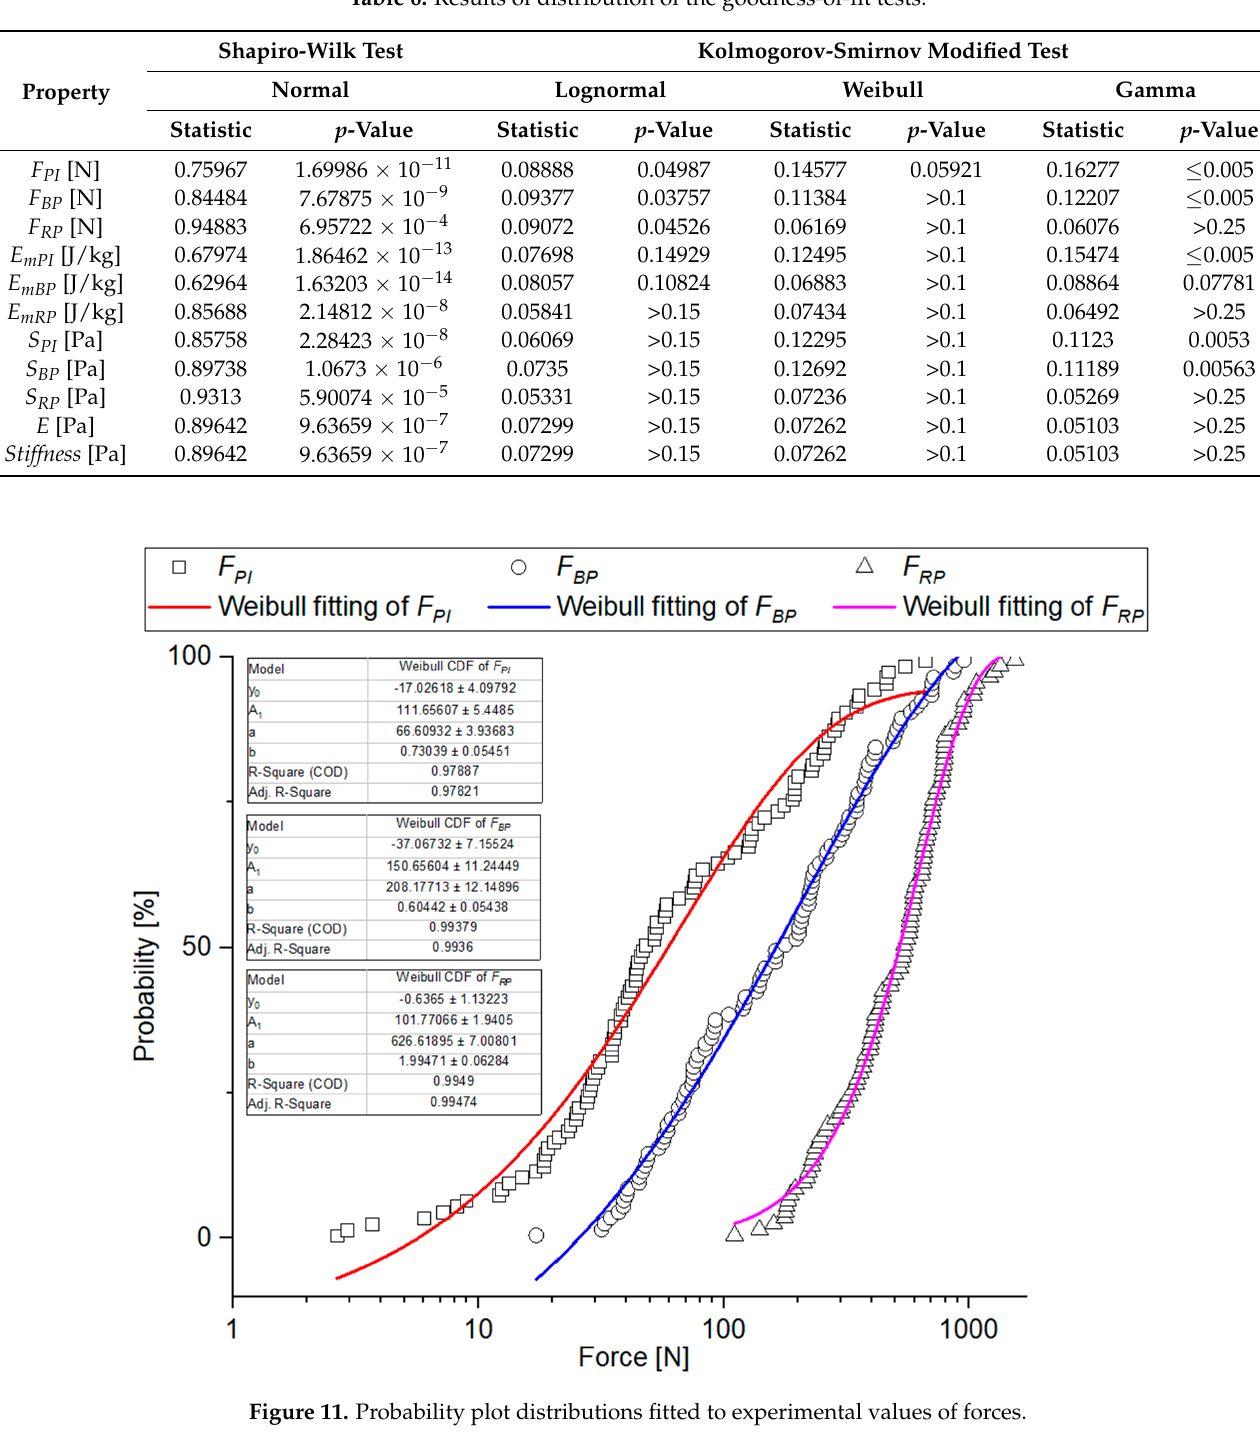
Figure 12. Probability plot distributions fitted to experimental values of specific energy.